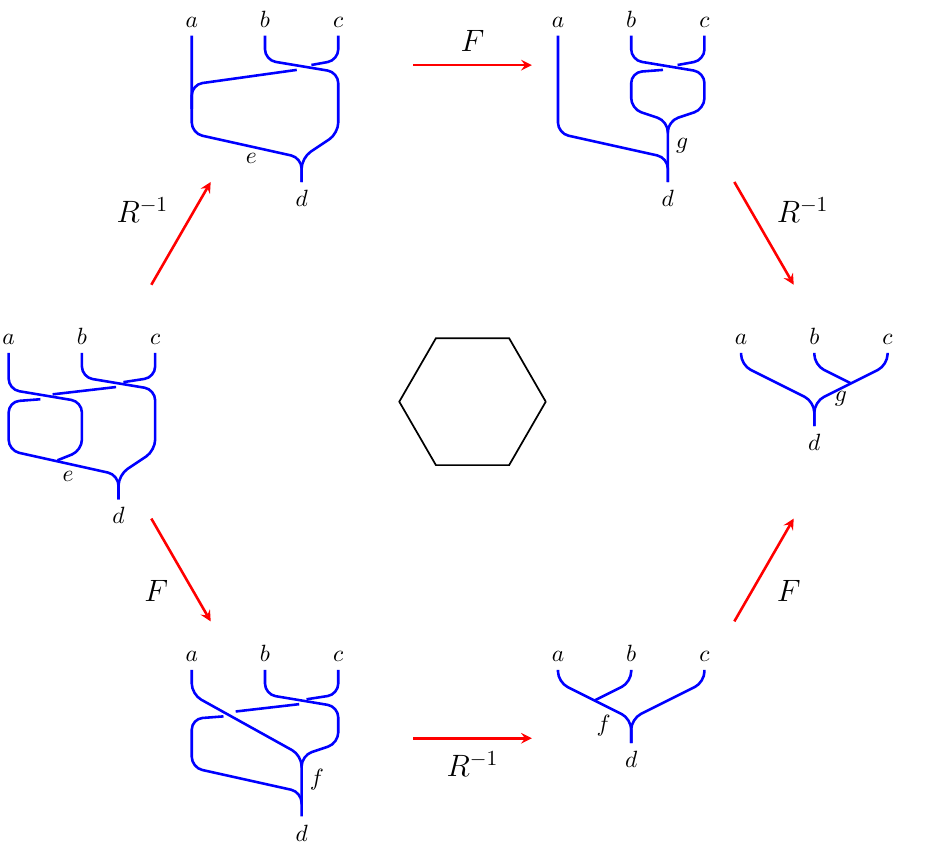
Figure 5 . The same idea applied to the F - and R − 1 -matrices leads to the alternate hexagon identity (2.9).